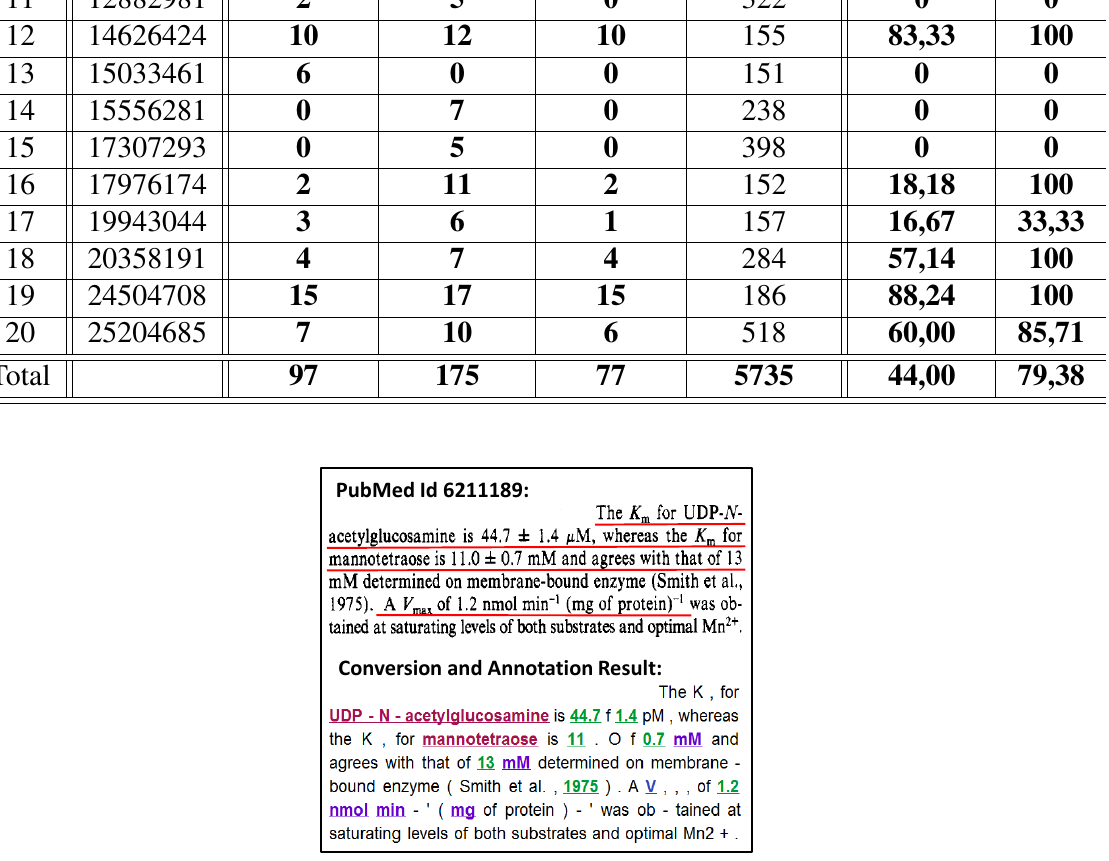
Figure 9: Comparison between original PDF and converted/annotated result showing some dis-